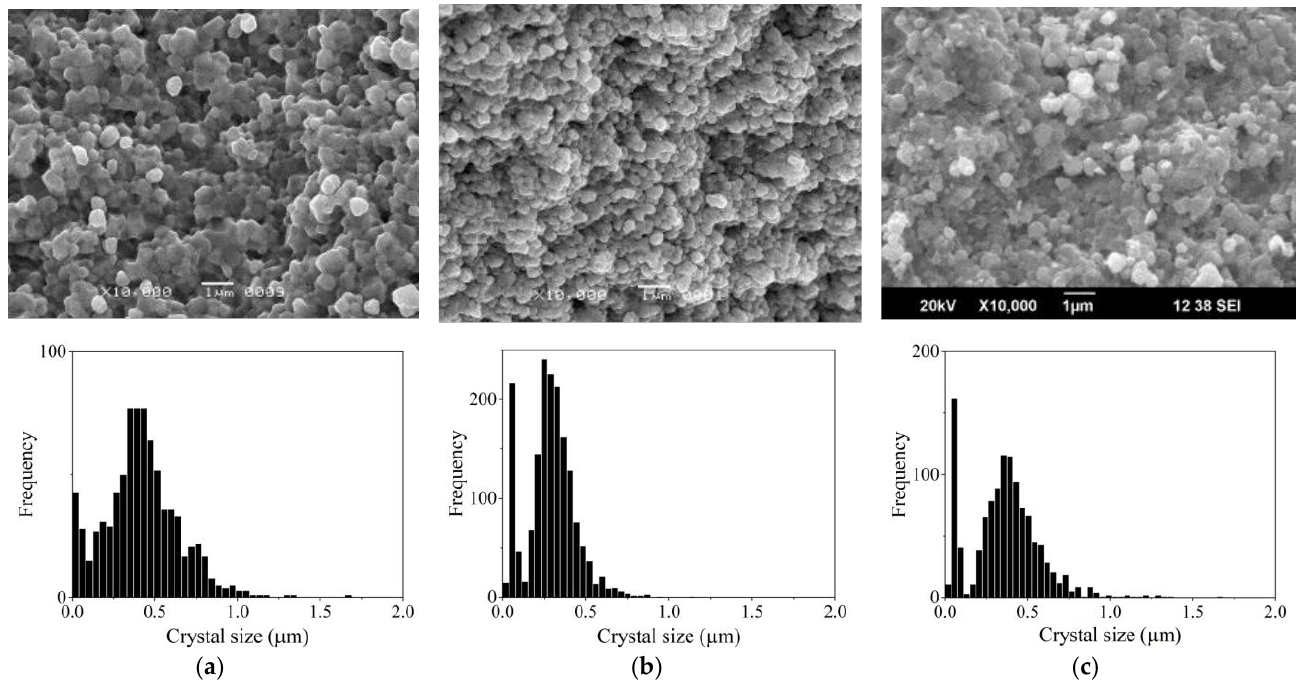
Figure 8. Microstructure and grain size distribution in CS samples of powder activated by impregnation with additive 0.3% ( a ), 1% ( b ), and 3% ( c ) AmCl.